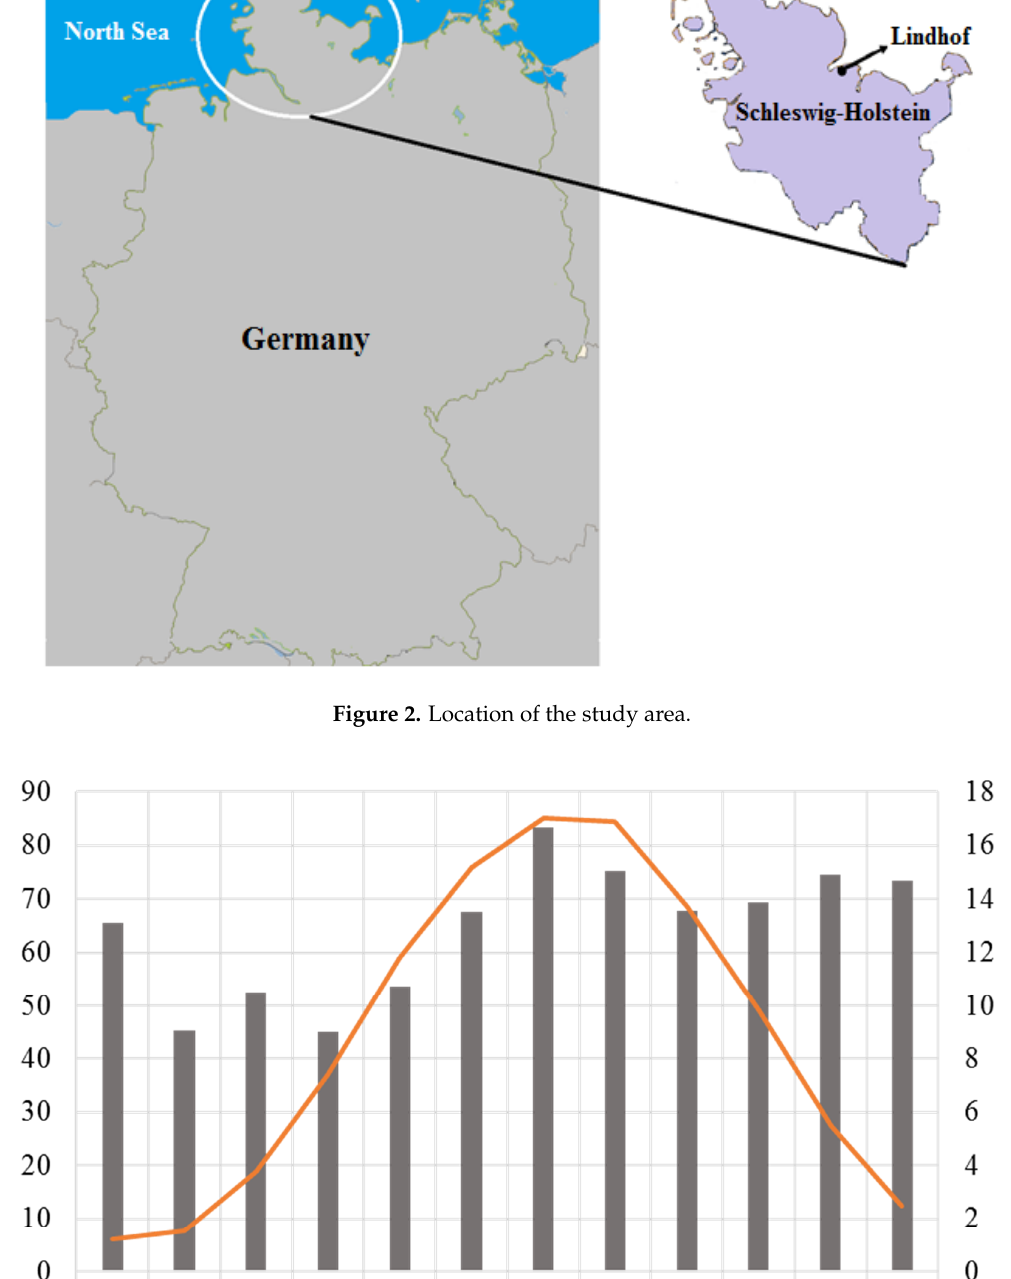
Figure 3. Average monthly precipitation and temperature in the study area (1961–2019).